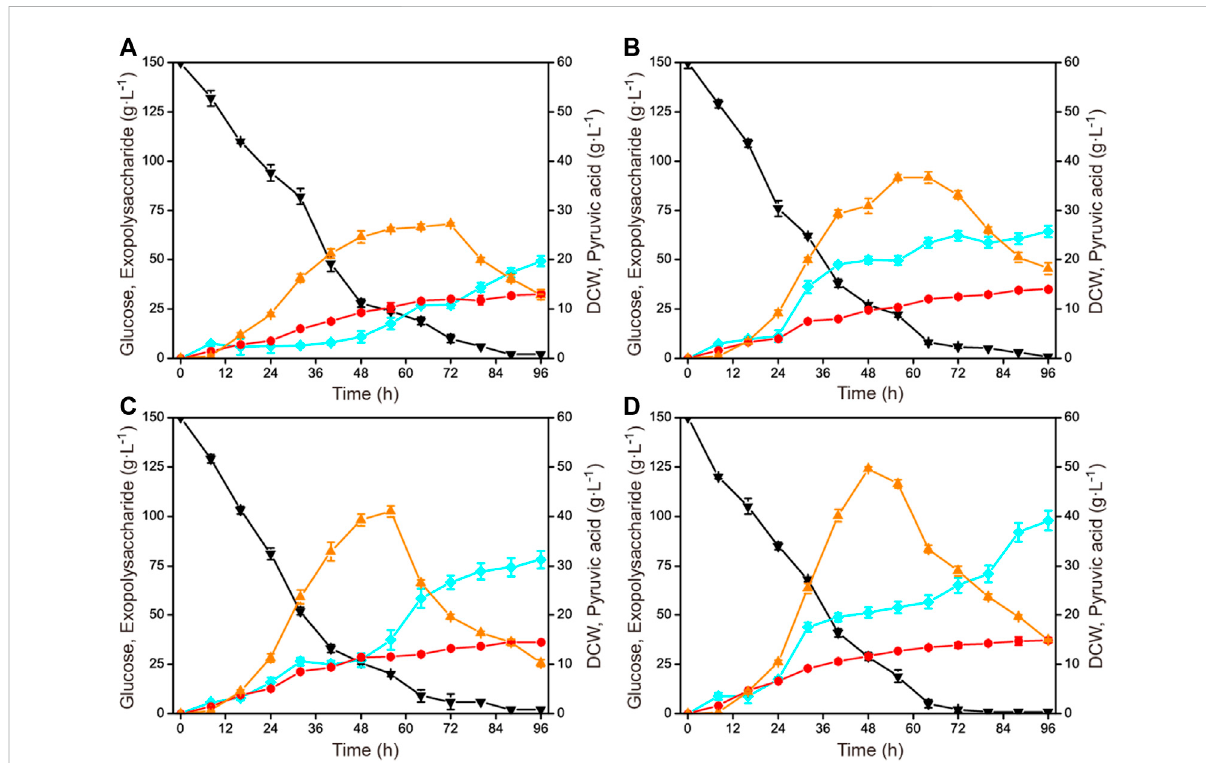
FIGURE 2 Time courses of exopolysaccharide production at different agitation speeds in a 1-L fermenter. (A) 1.0 vvm and 300 rmin − 1 . (B) 1.0 vvm and 400rmin − 1 . (C) 1.0vvmand500rmin − 1 . (D) 1.0vvmand600rmin − 1 .Blackdowntriangles,glucose;orangeuptriangles,pyruvicacid;redcircles,DCW; blue squares,